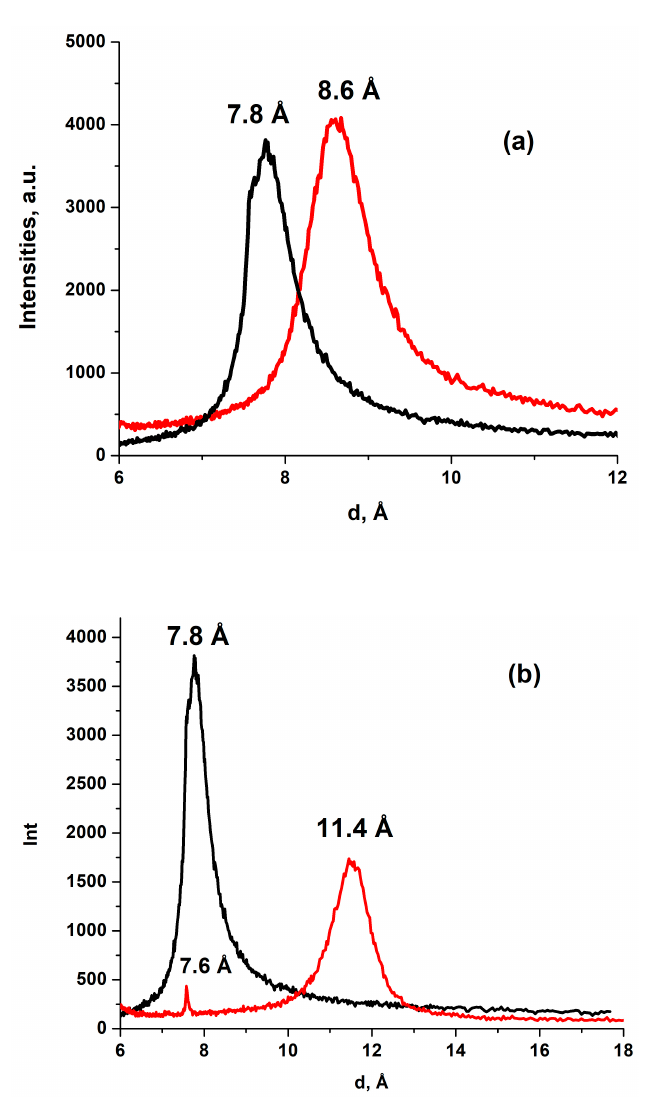
Figure 5. XRD of mHGO before (black line) and after (red line) sorption of acetonitrile ( a ) and pyridine ( b ).